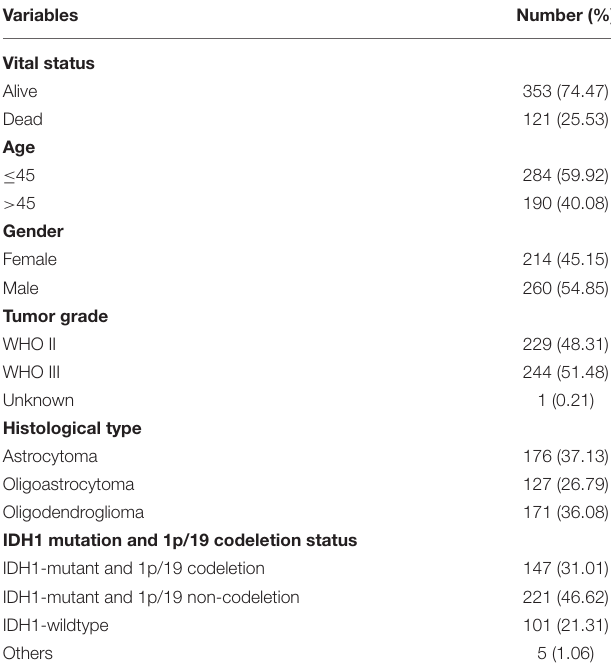
TABLE 1 | Clinical characteristics of 474 LGG patients from TCGA cohort included in this